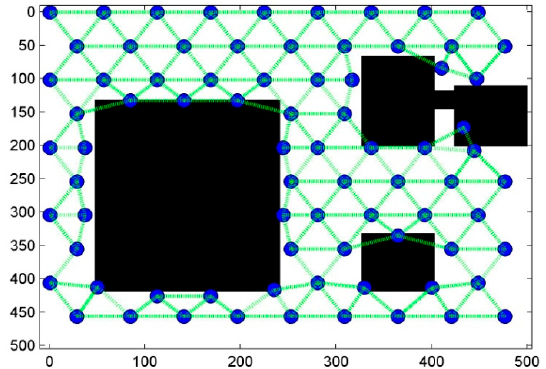
Figure 23. Illustration of the UL-B network connection graph.